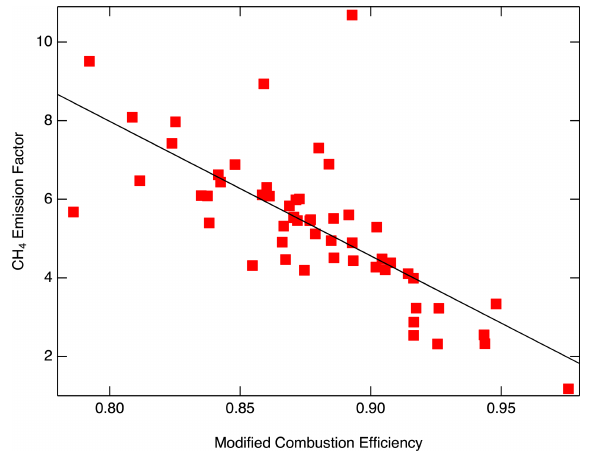
Figure 6. Relationship between the CH 4 emission factor and modi- fied combustion efficiency (MCE). The strong linear relationship in- dicates that periods with more smoldering combustion (and a lower MCE) produce significantly higher levels of CH 4 emissions. The relationship was defined by a slope of − 46.77 ± 4.70, a y intercept of 46.37 ± 4.13gkg − 1 dry biomass burned, an r 2 of 0.54, and a significance value of p < 0.01.